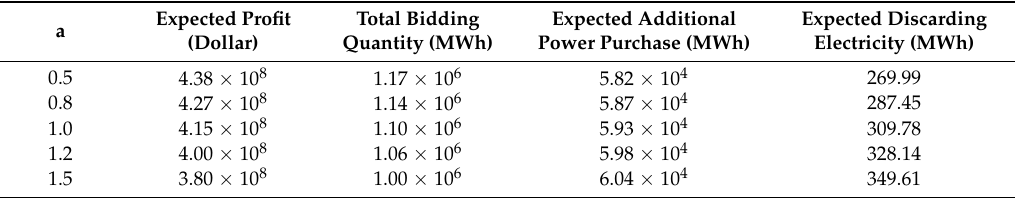
Table 3. The effect of the variance of wind power on